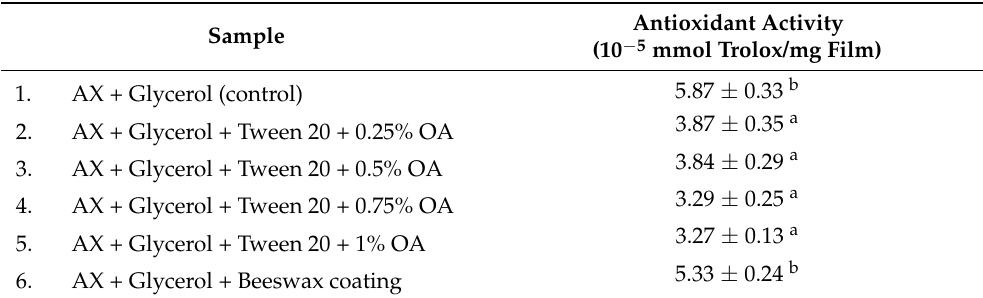
Table 10. Antioxidant activity (10 − 5 mmol Trolox/mg film) of all the film samples. Values in the same column followed by different superscript letters differ significantly ( p <